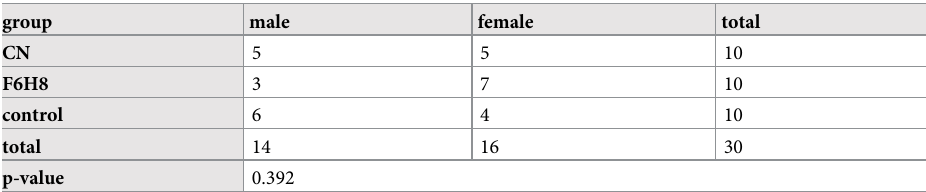
Table 1. Gender distribution (short term analysis group).